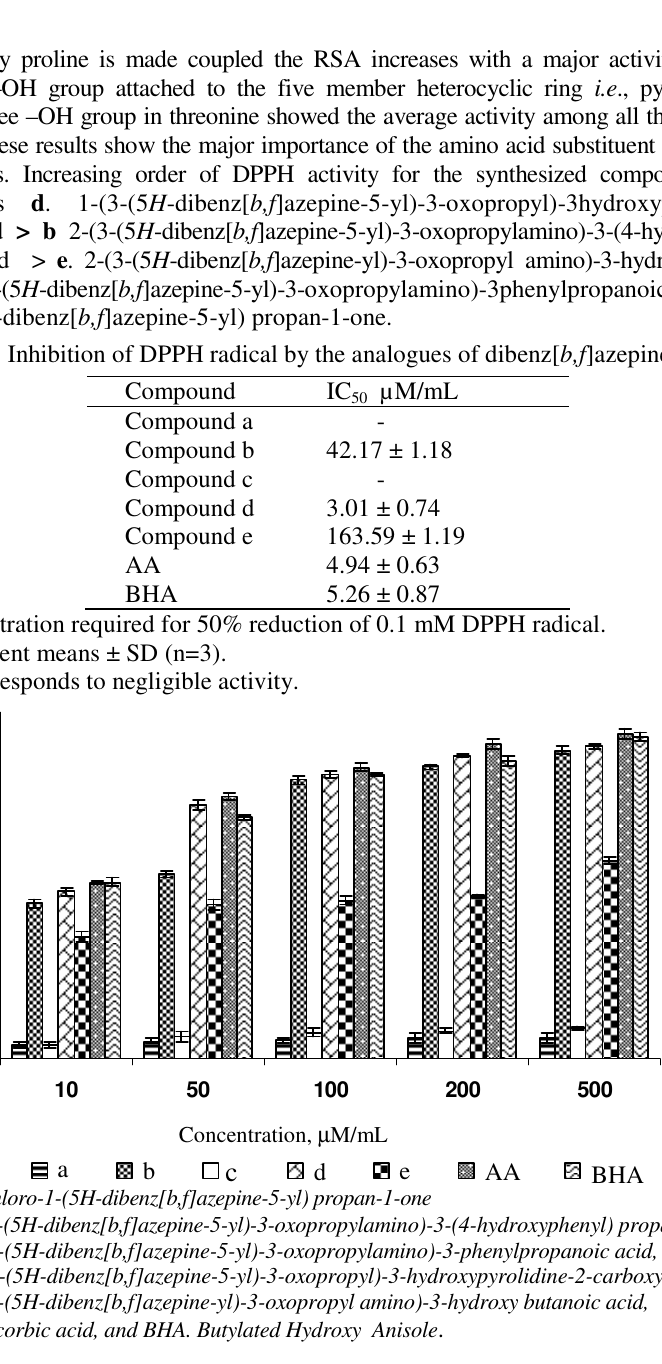
Figure 1. DPPH free radical scavenging ability for 3-chloro-1-( 5H -dibenz[ b,f ]azepine-5-yl) propan-1-one and its amino acid analogues. Values represent means ± SD (n =